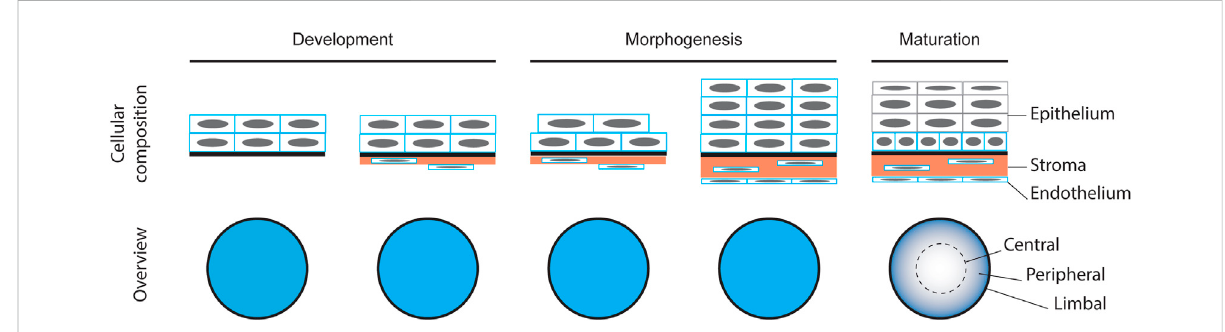
Schematic representation of corneal formation based on the existing